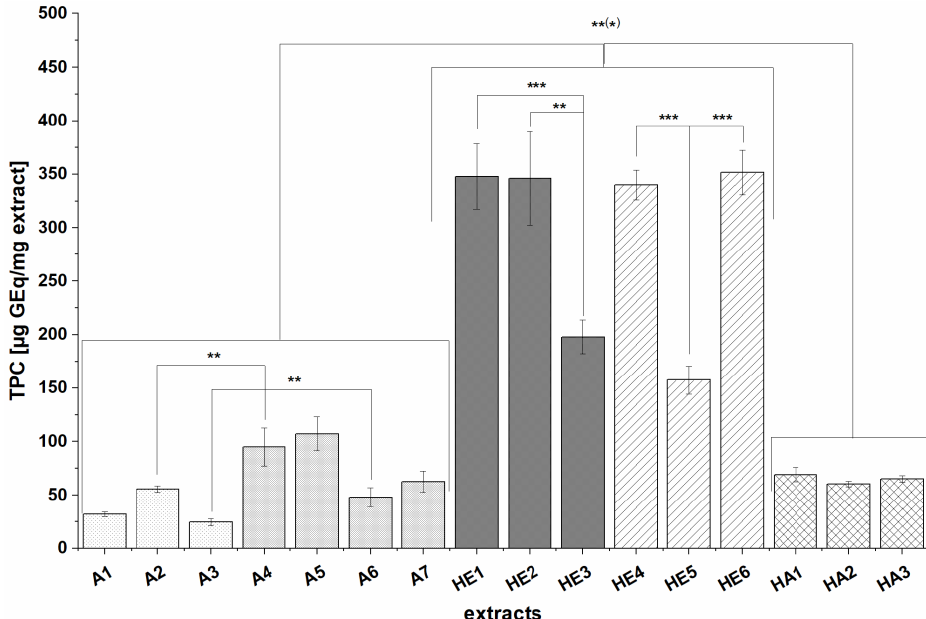
Figure 1. TPC (total phenolic content) of extracts expressed in units of µg GEq/mg extract. Values are expressed as means ± SD of three to five independent experiments each performed in triplicate; significant differences between and within different extract groups were analyzed: ** p < 0.01, *** p < 0.001.